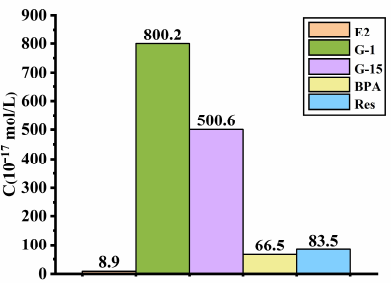
Figure 6. Interconnected allosteric constants of estrogens and their analogs determined by a self- assembled double-layer gold hGPER electrochemical receptor sensor.